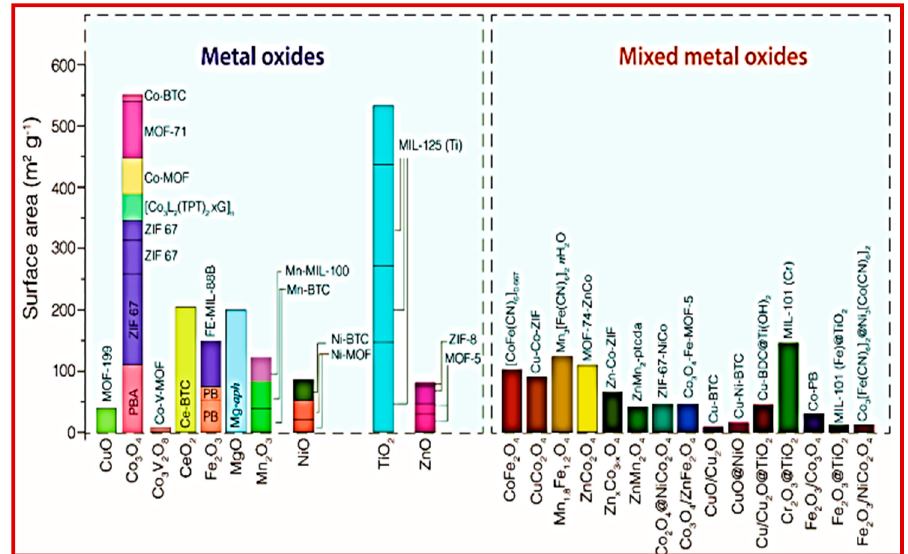
Figure 11. The development of the metal organic framework (MOF) synthesis derived from porous metal oxides (MOs). Bar graphs presentating a variation of MOF precursors, which have been utilized to arise MOs nanostructures (CuO [164], Co 3 O 4 [165–172] Co 3 V 2 O 8 [173], CeO 2 [174], Fe 2 O 3 [175–177],